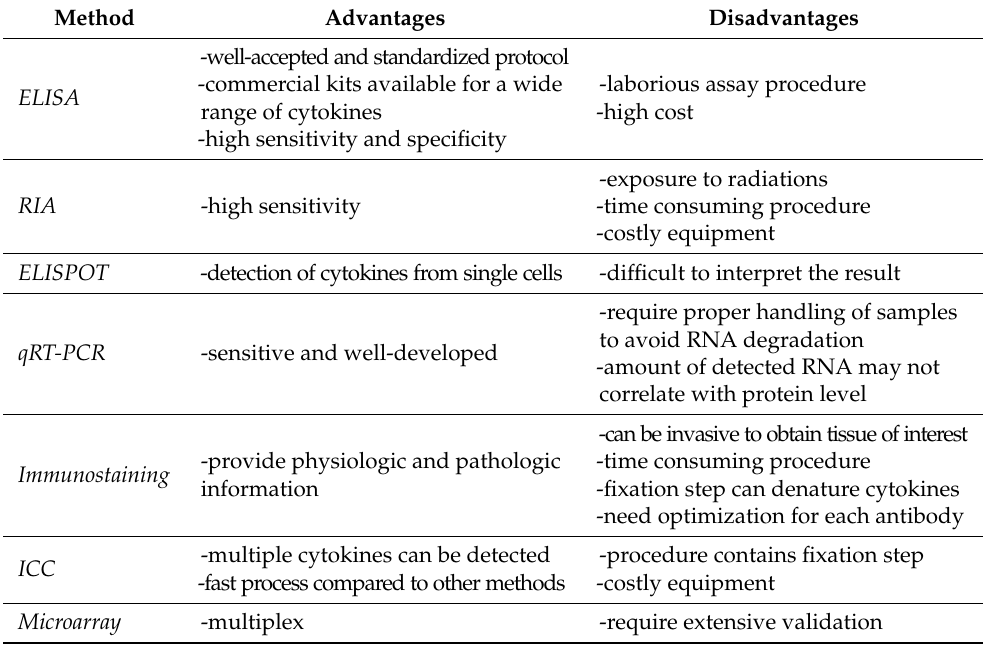
Table 2. Advantages and disadvantages of the discussed conventional techniques for cytokine